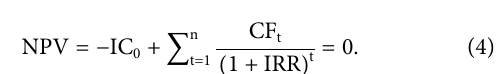
Frontiers in Energy Research |